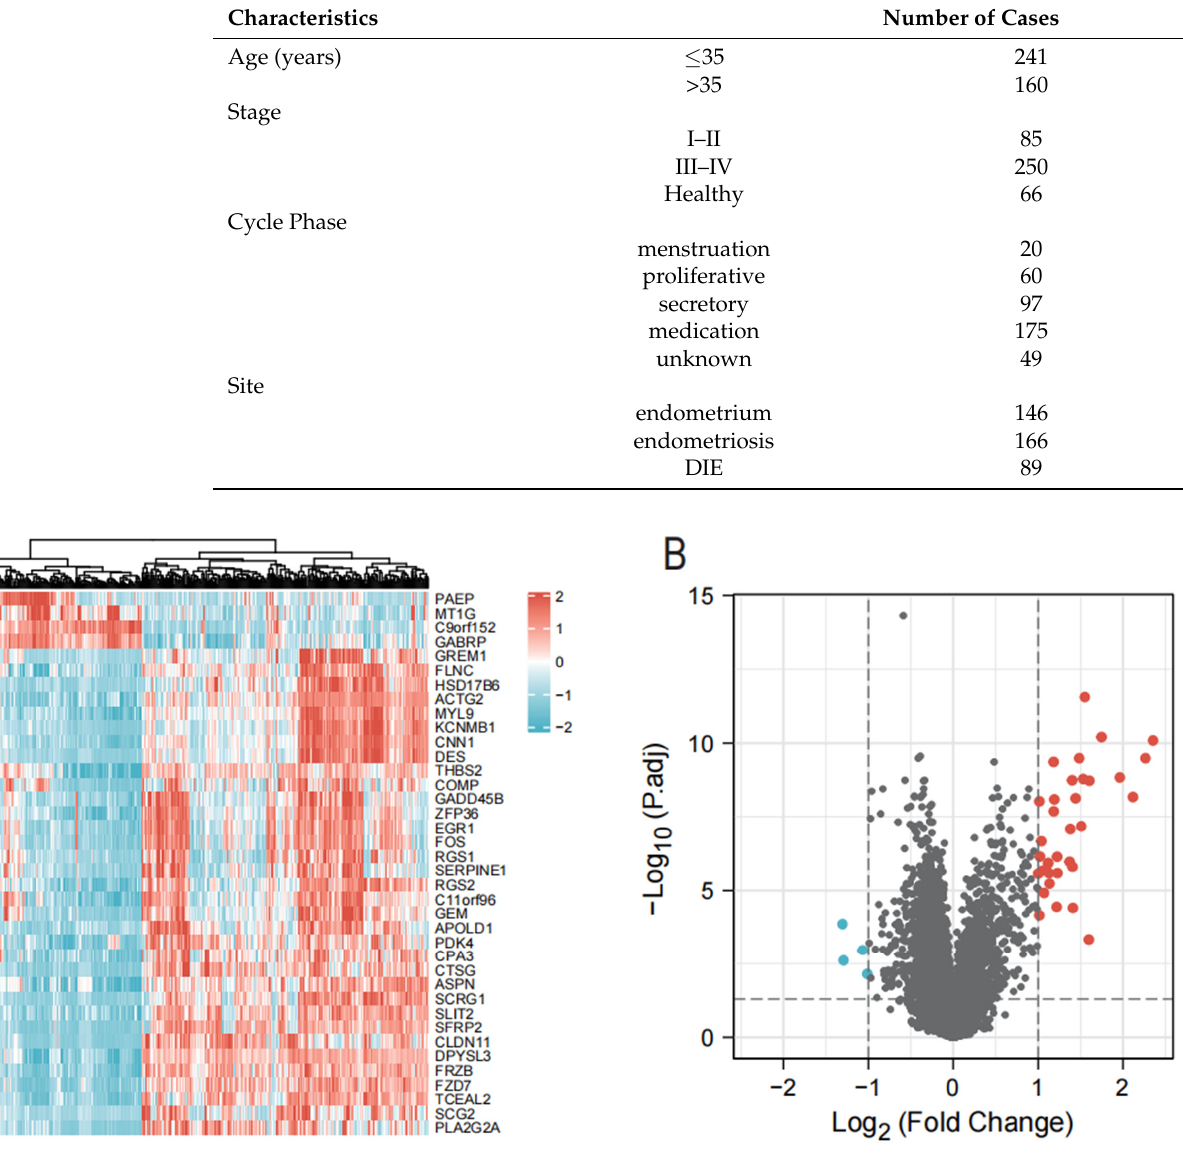
Figure 1. Differentially expressed genes (DEGs) of GSE141549. ( A ) Heat maps of 38 DEGs found in endometriosis tissue versus control samples. ( B ) DEG volcano plot of endometriosis tissue and control samples.